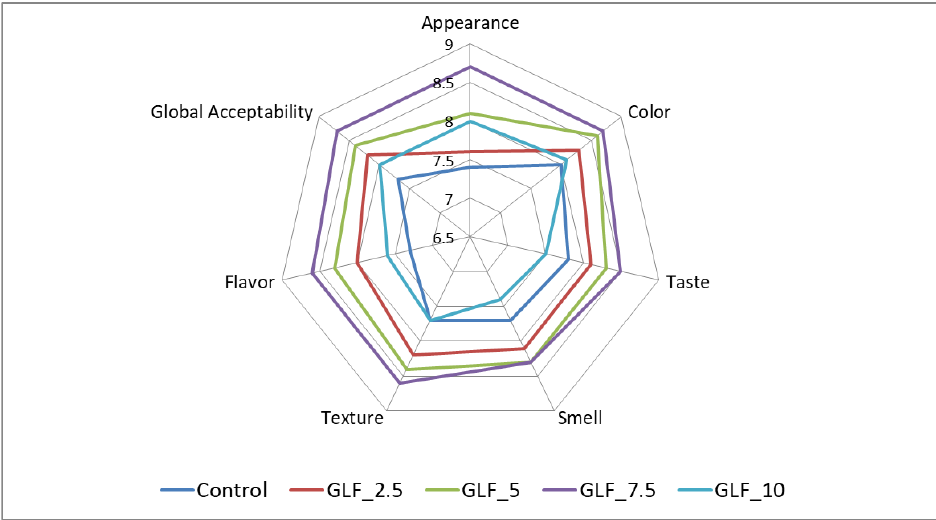
Figure 3. Sensory analysis of bread samples .